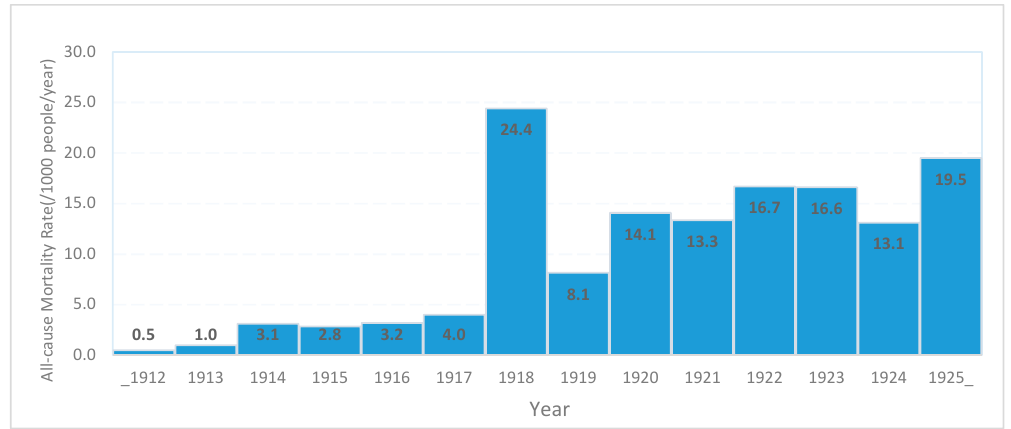
Figure 3. Health facility use rates of Coast Province Kenya, 1912–1925. * Missing data, only Mombasa data reported. Lamu and Tana River districts data missing for years 1917, 1918, 1919 and 1921.